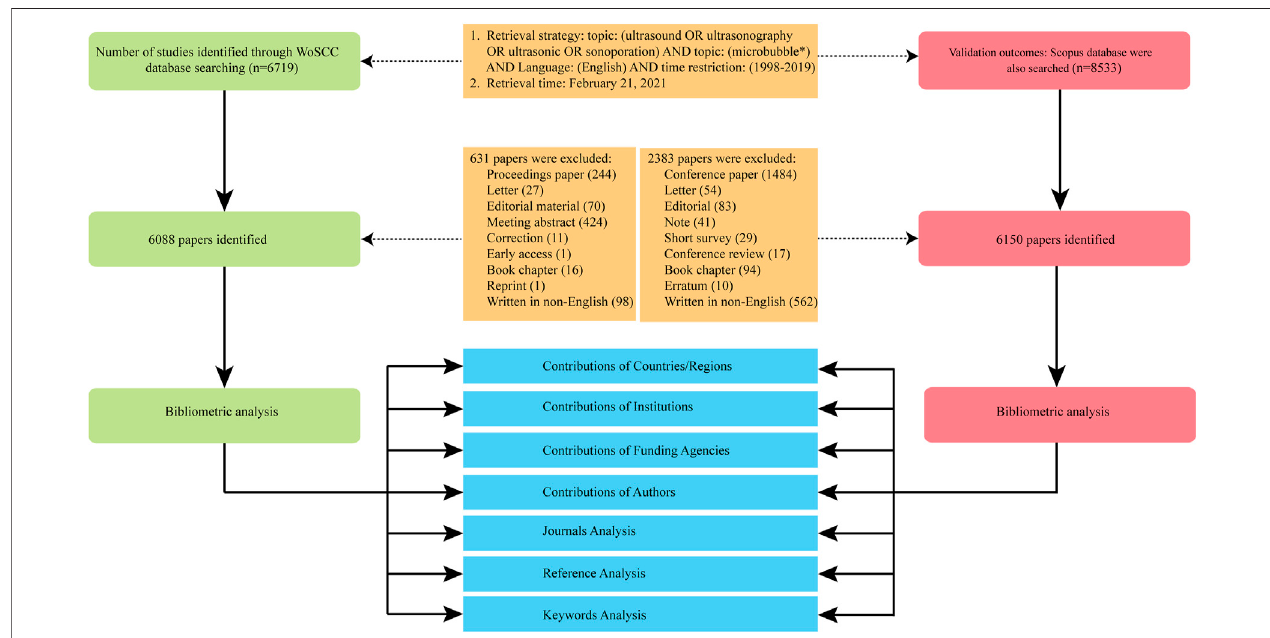
FIGURE 1 | Flow diagram of literature fi